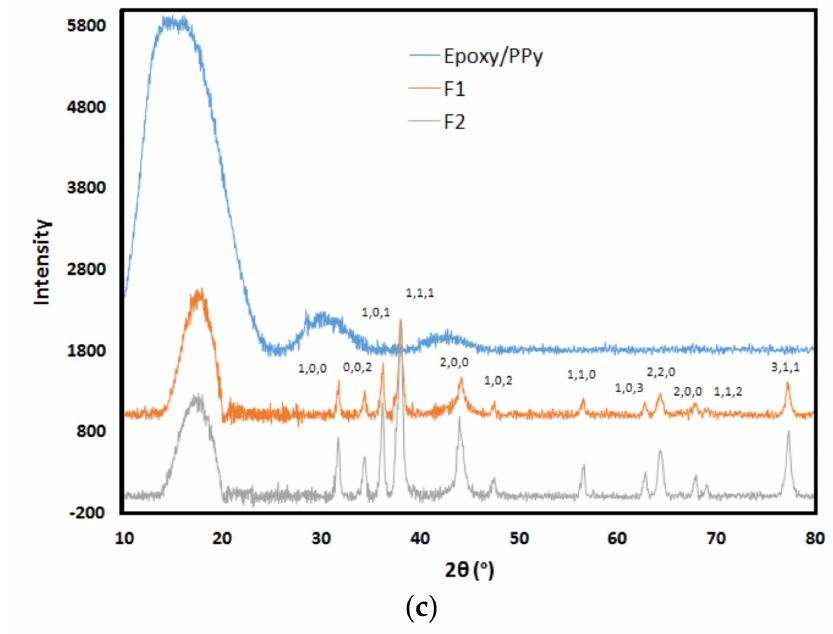
Figure 3. X-ray di ff raction (XRD) patterns of ( a ) ZnO nanoparticles, ( b ) Ag nanoparticles, and ( c ) the perpared formulations of epoxy / PPy, F1, and F2.